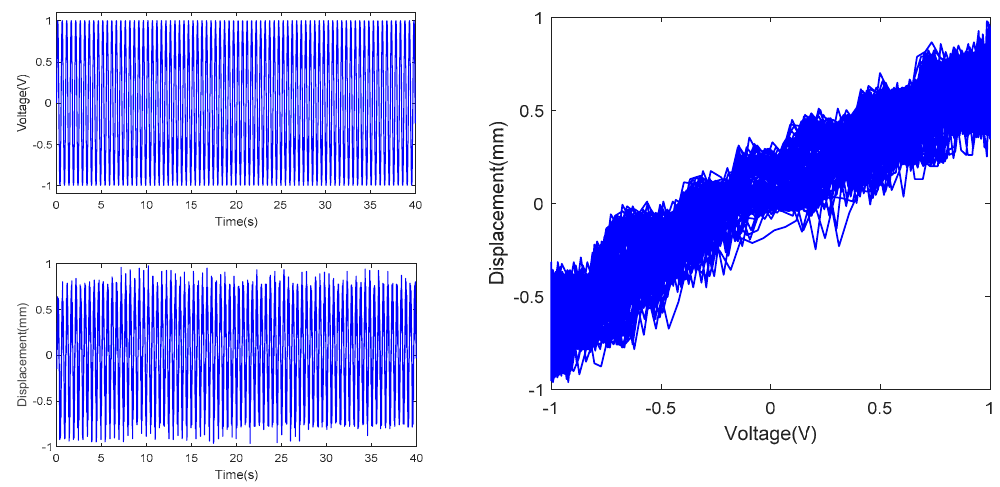
Figure 6. Tip displacement at actuating voltage with amplitude of 1V and frequency of 5/2 π Hz.